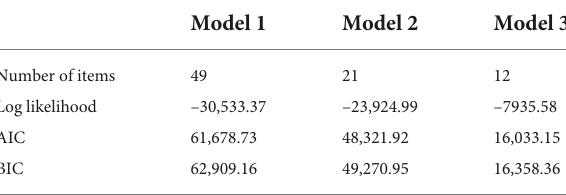
TABLE 3 Model fit statistics for confirmatory factor analysis iterations of the Whole food Plant-Based Diet